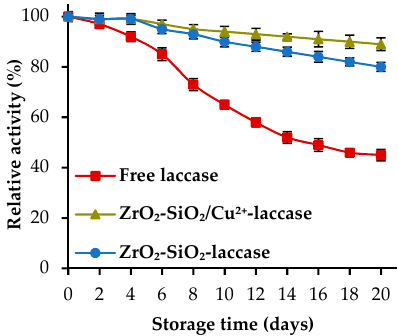
Figure 6. Storage stability of the free and immobilized enzyme over 20 days of storage.